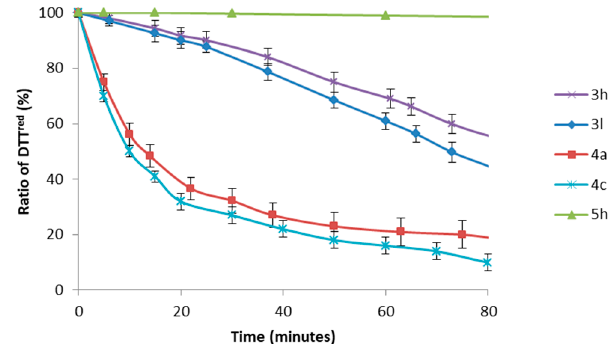
Figure 1. Oxidation of DTT red with H 2 O 2 in the presence of Se- or S-containing catalysts (10 mol%). Reaction conditions: [DTT red ] 0 = 0.14 M, [H 2 O 2 ] 0 = 0.14 M, [catalyst] = 0.014 M, CD 3 OD (0.6 mL). Reaction progress was monitored by means of 1 H NMR. The mean ± SD values of three separate experiments are reported.